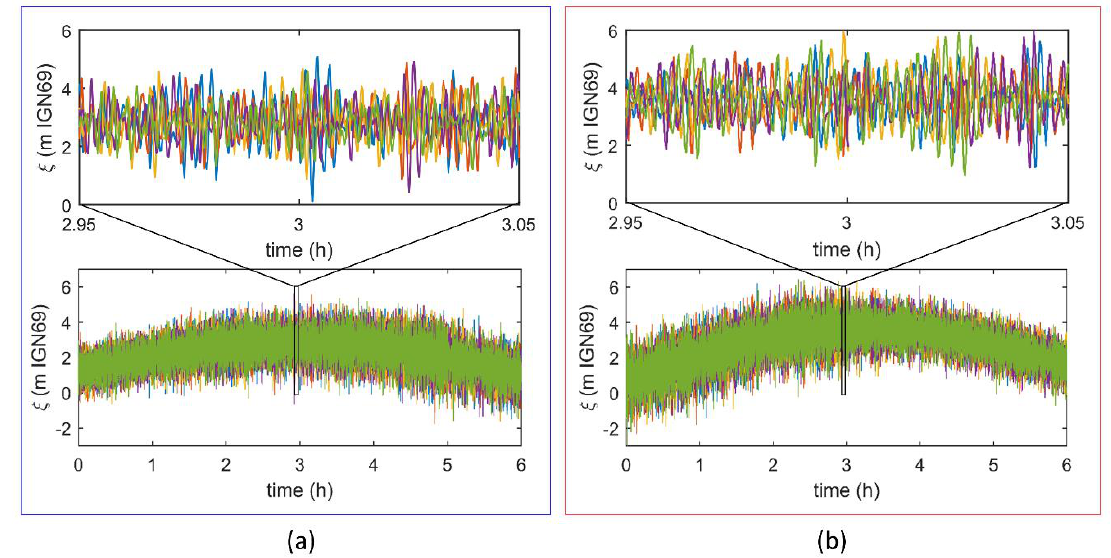
Figure 6. Instantaneous water level (denoted ξ ) at the southern boundary (point P, Figure 1) of the computational domain of the SWASH model, for the 27/10/2004 ( a ) and 10/03/2008 ( b ) events, with 5 simulations per event.